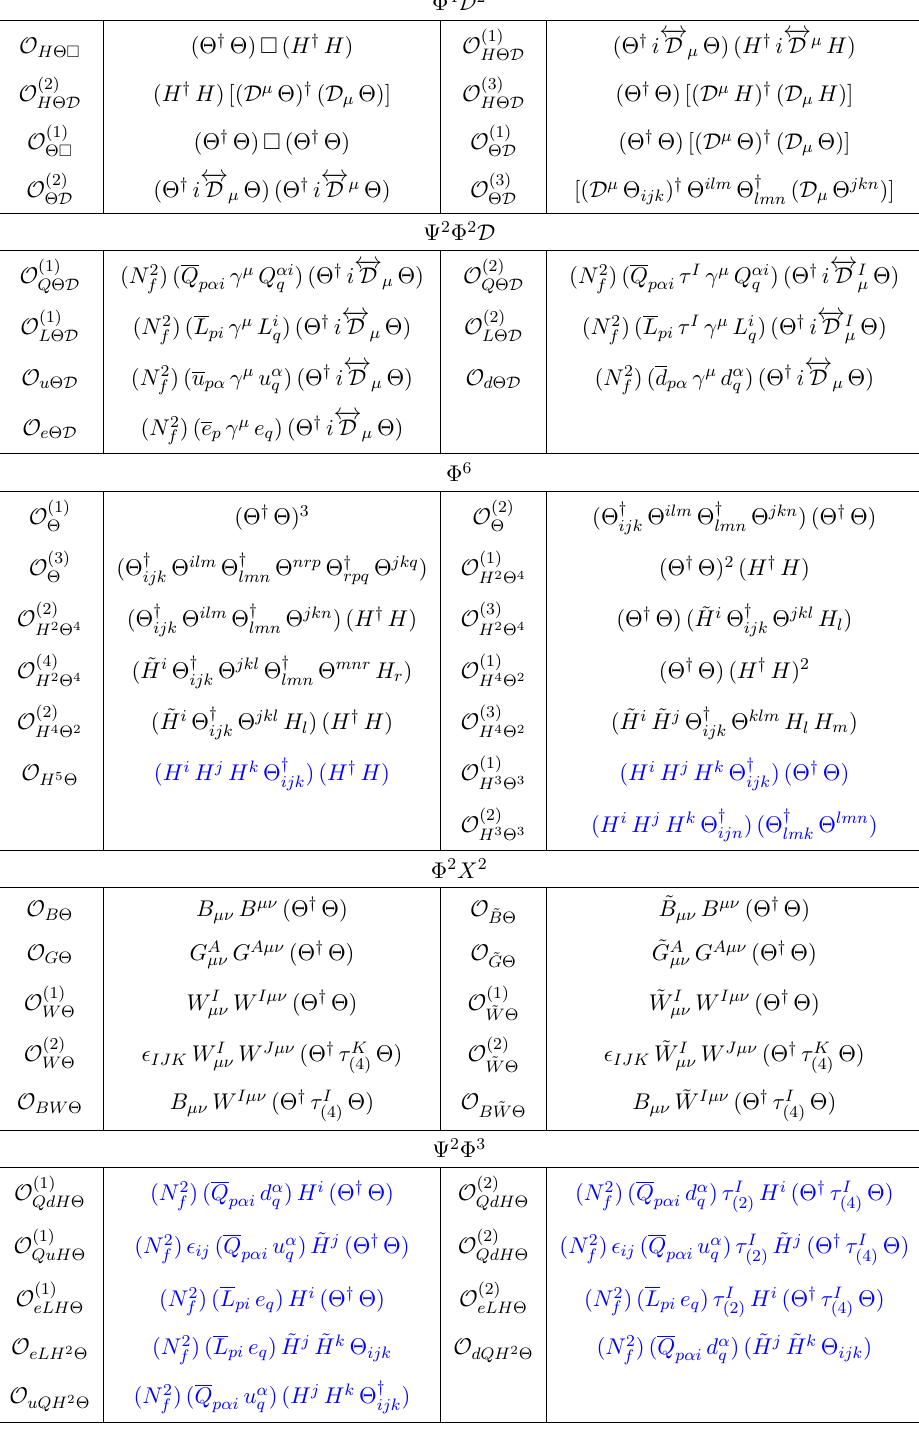
Table 33 . SM extended by SU(2) Quadruplet Scalar ( Θ ): additional operators of dimension 6. Here i, j, k, l, m, n and α are the SU(2) and SU(3) indices respectively. τ I generators in 2 × 2 and 4 × 4 representations respectively. A = 1 , 2 , · · · , 8 and I, J, K = 1 , 2 , 3 . p, q = 1 , 2 , · · · , N f are the flavour